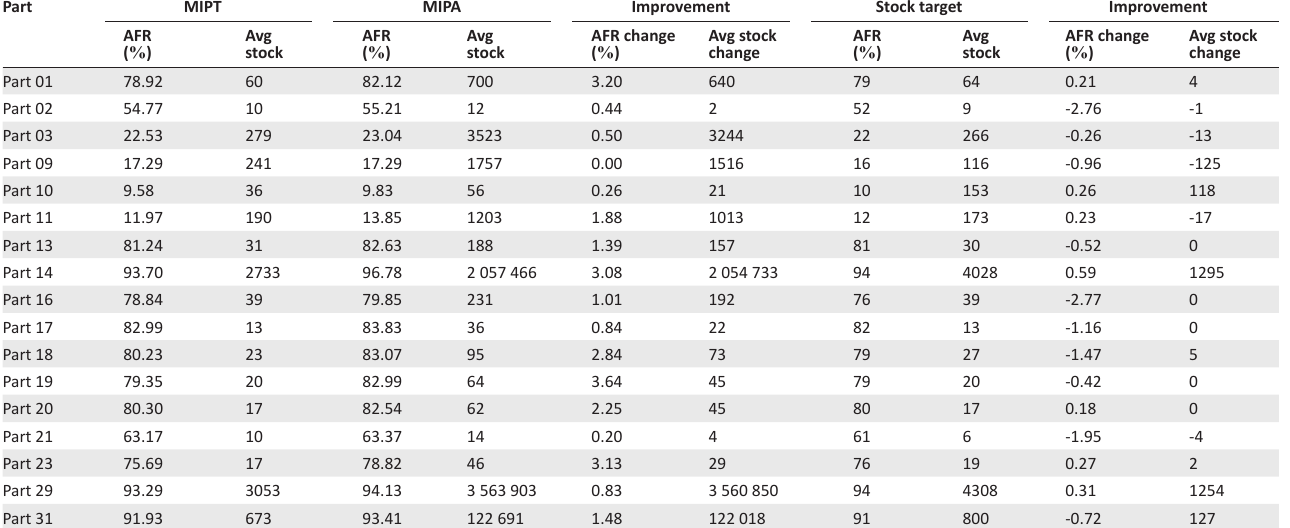
TABLE 6: Results of simulating actual demand data for slow moving local parts.